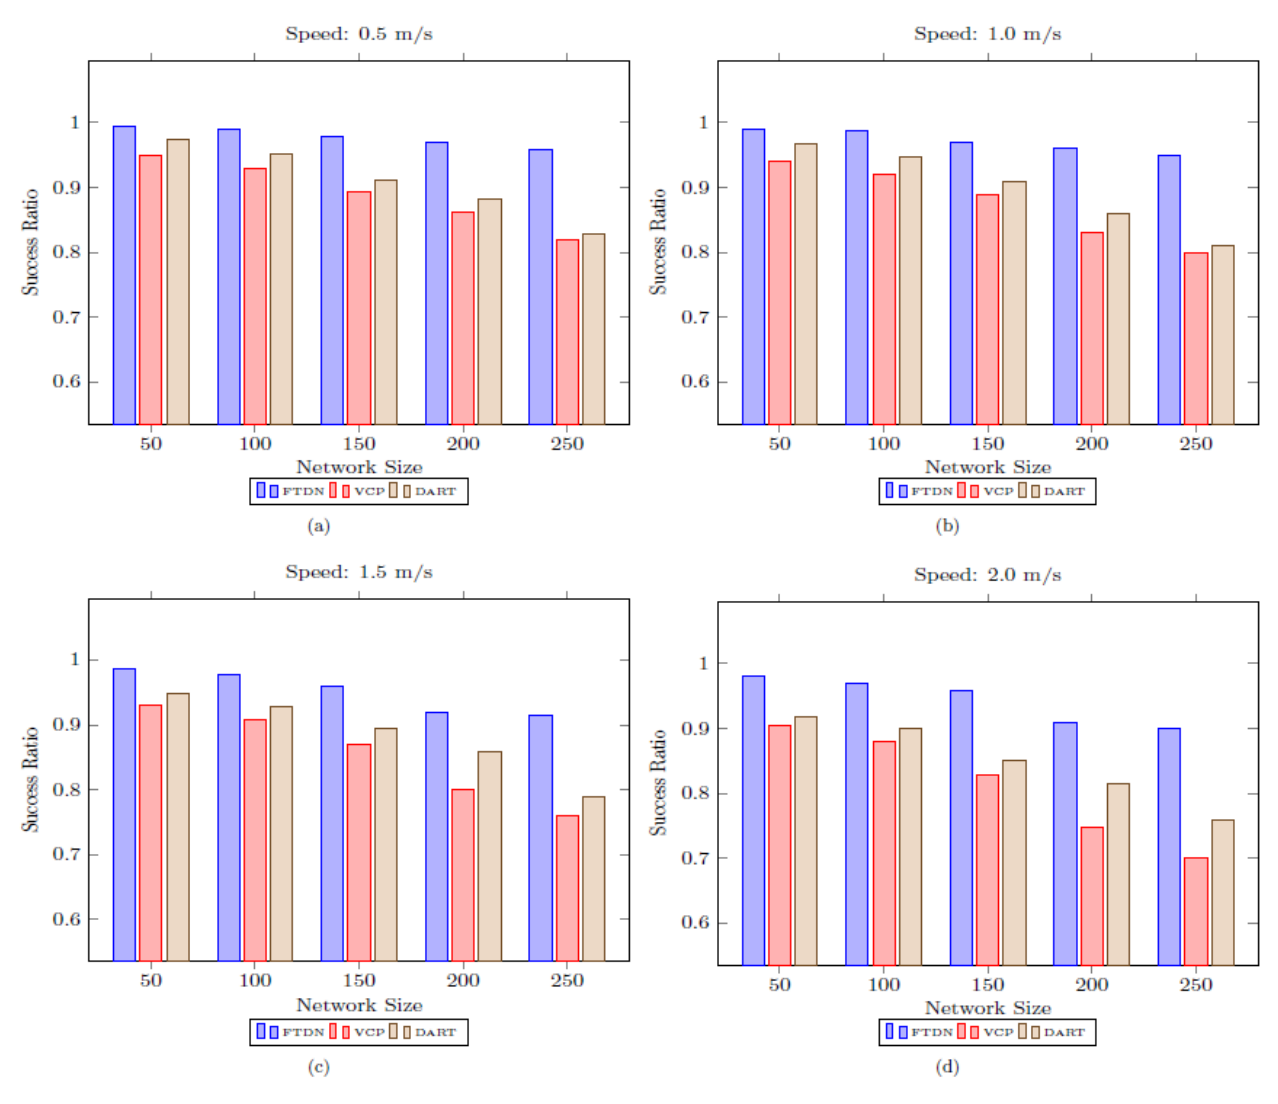
Figure 5. Lookup success ratio as a function of network size and